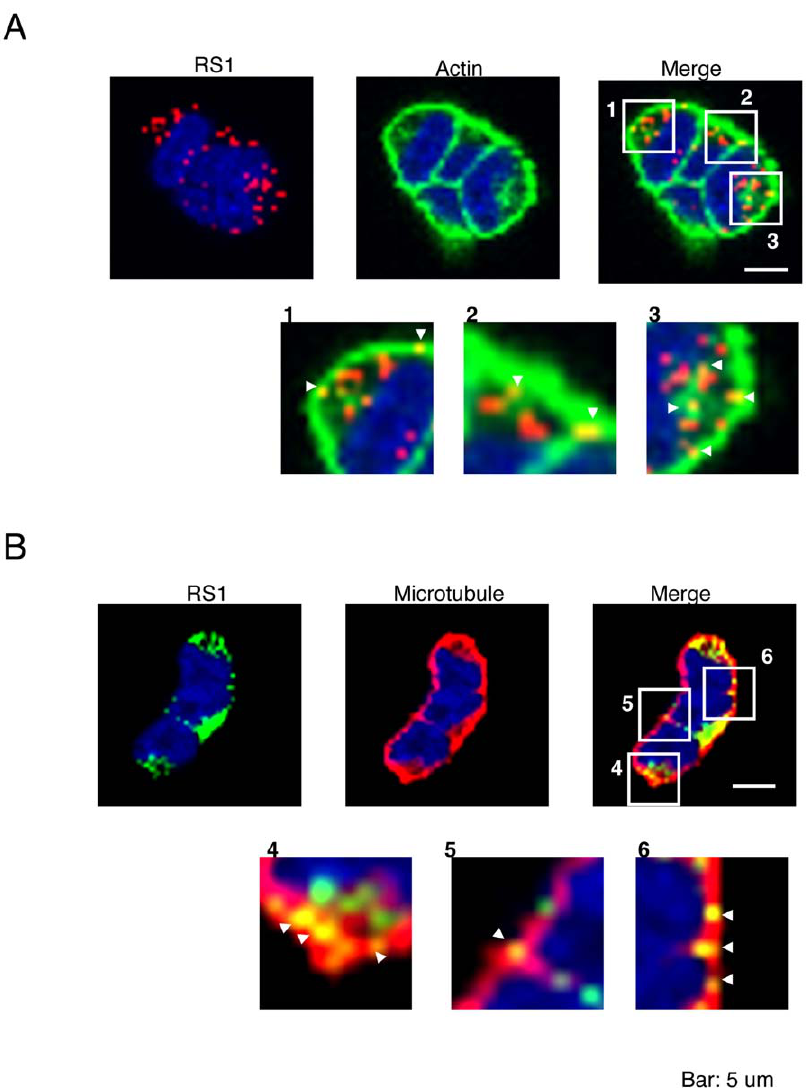
Figure 1. Confocal microscopy images of Weri-Rb1 cells. (A) Cells were double-stained using the rabbit RS24-37 retinoschisin antibody followed by Cy3-conjugated donkey-anti-rabbit IgG (RS1, red) and Alexa Fluor 488-phalloidin for F-actin (green). DAPI labeled the nuclei (blue). The right image corresponds to the merged RS1 and F-actin images. The white squares limit Areas 1, 2 and 3 that have been zoomed in below. (B) Cells were double-stained for retinoschisin with RS24-37 antibody followed by Alexa Fluor 488 goat anti-rabbit IgG (green) and alpha tubulin antibody followed by Alexa Fluor 568 goat anti-mouse IgG (red). Nuclei were labeled with DAPI (blue). A merged image of the cells labeled for RS1 and alpha- tubulin is at the right. Retinoschisin co-localized with the cytoskeleton proteins F-actin and alpha-tubulin as indicated by the arrowheads in the enlarged images (1–6). Bar, 5 m m.